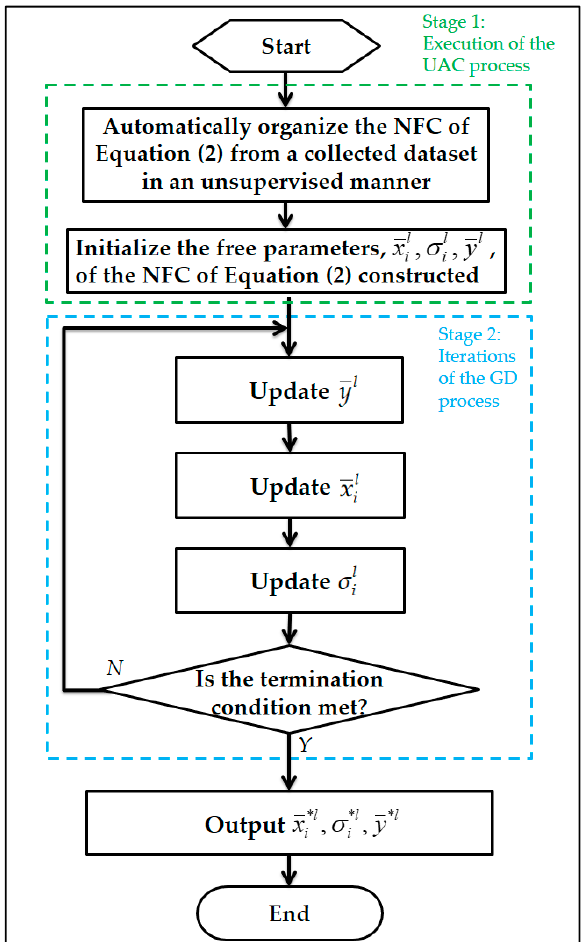
Figure 4. Flowchart of the hybrid UAC-NFC model conducted in the HEMS for NILM and proposed in this article.